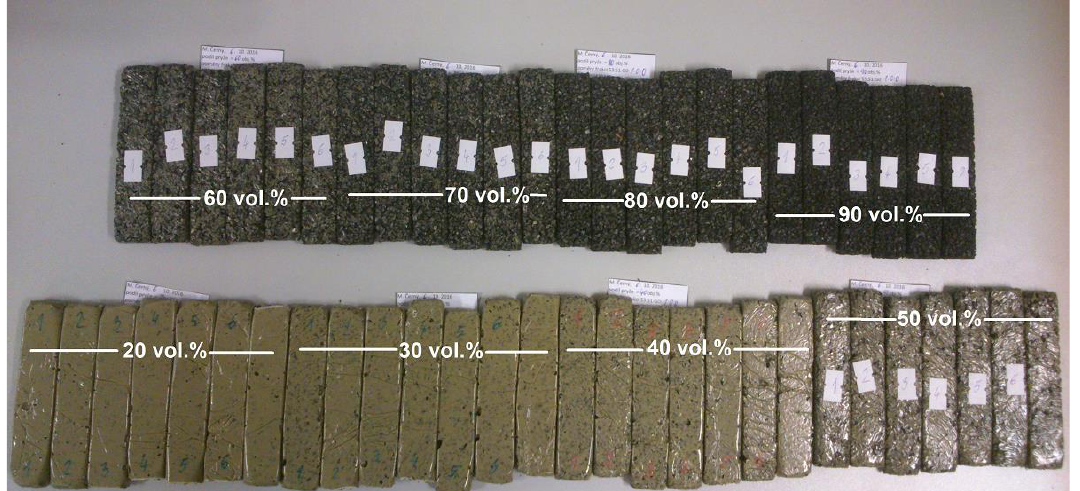
Figure 1. Example of samples before tensile testing. In the figure, there are samples composed of P 33 -CO 17 -Si 50 matrix and 20 – 90 vol.% rubber filler R 2 (if porosity is neglected). The filler content is indicated by white text and attached white lines added to the original figure. Notice: Highly filled specimens in the figure (90 vol.% filler) were not able to be tested due to their nonsolid nature. These specimens are not included in data